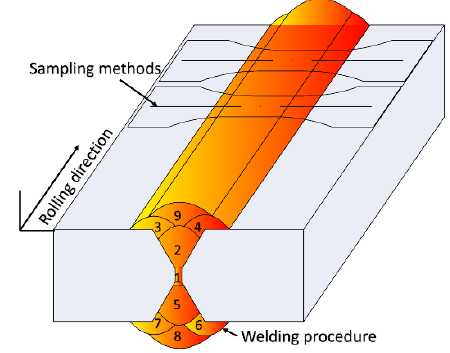
Table 2. The parameters of the welding process.